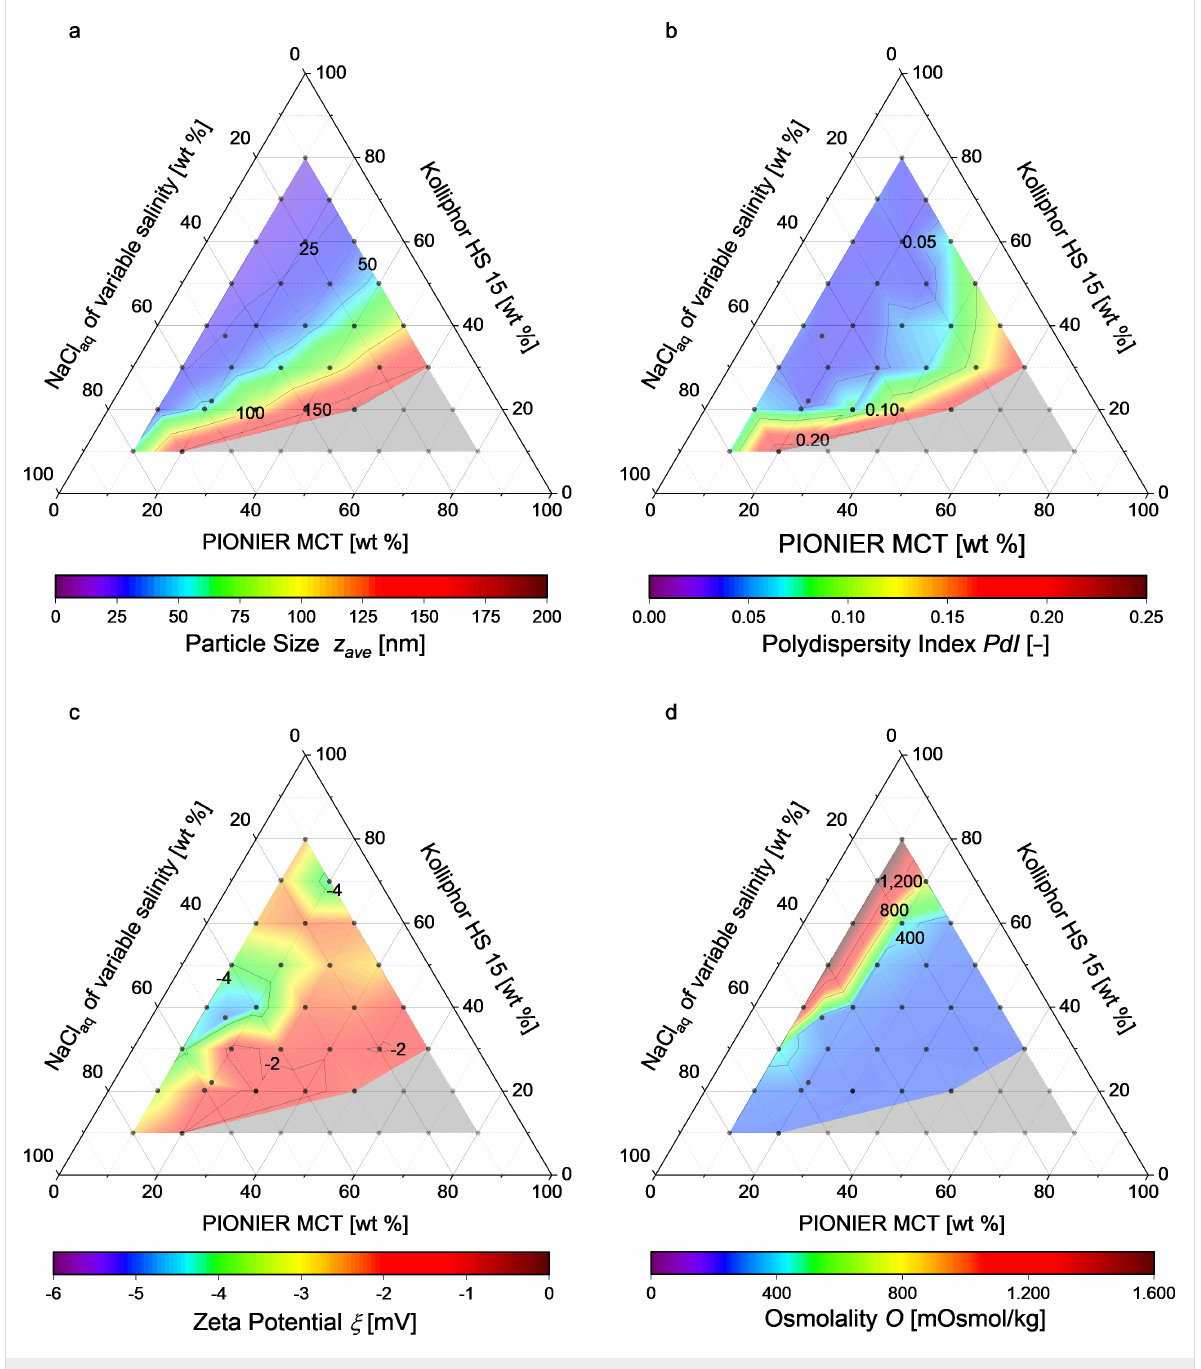
Figure 4: Ternary phase diagrams showing (a) the resulting particle diameter, (b) the PDI, (c) the zeta potential and (d) the osmolality. Each dot represents a certain solution composition. The formation of stable nanoemulsions occurs in the colored zone, while creaming coalescence or no phase inversion were observed in the grey